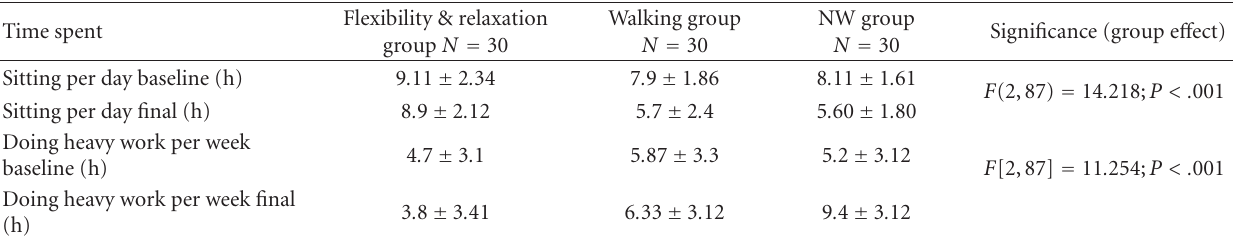
Table 5: Time spent sitting per day and doing heavy work per week.